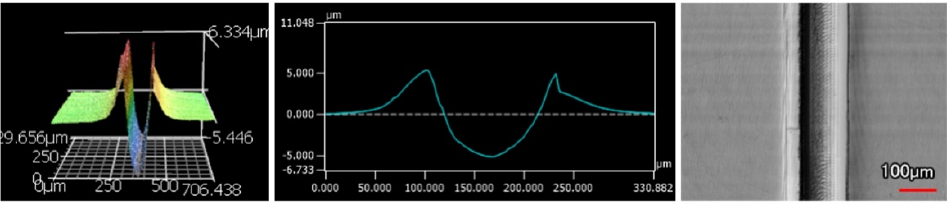
Figure 13. 9 μ m Thick Ni-P Coating 100 Passes of the Sharp Indenter.